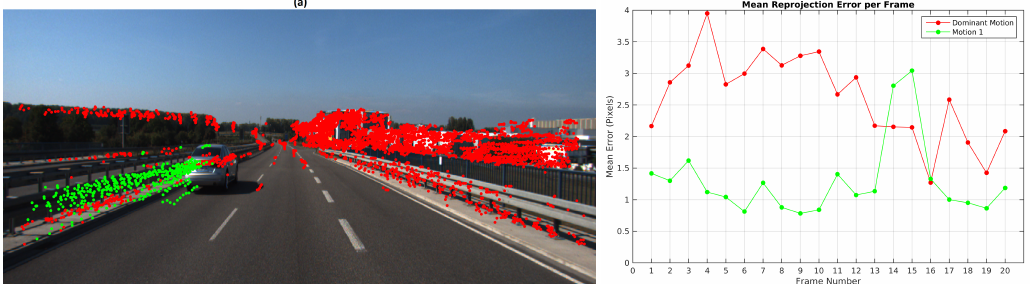
Figure 20. TbD-SfM results for Scene 1: ( a ) Motion segmentation; ( b ) Mean reprojection error.